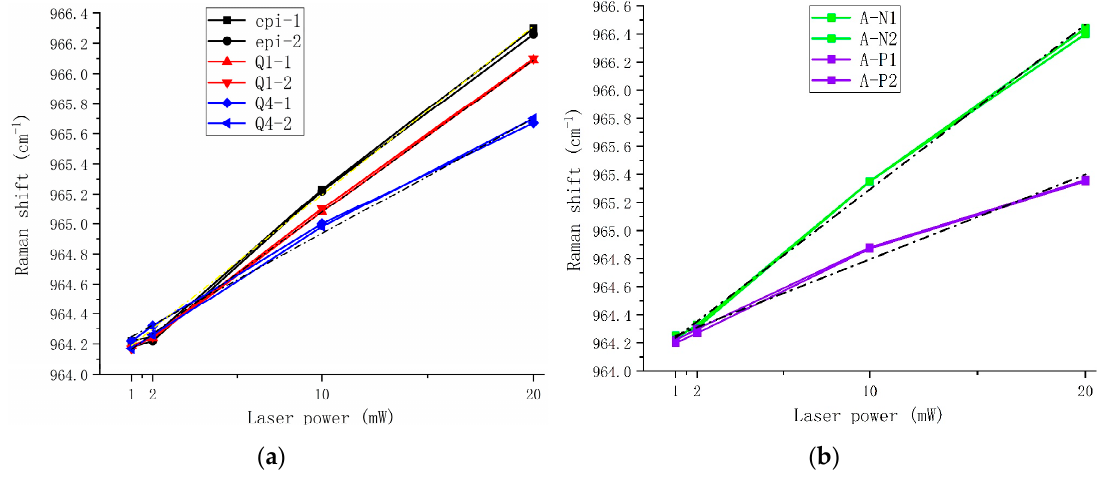
Figure 9. LOPC pgc mode Raman peak position for different samples as a function of laser power: ( a ) For epi and Q series samples, ( b ) for A-N and A-P samples. Labels 1&2 mean two measurements at different positions on the same measured sample.